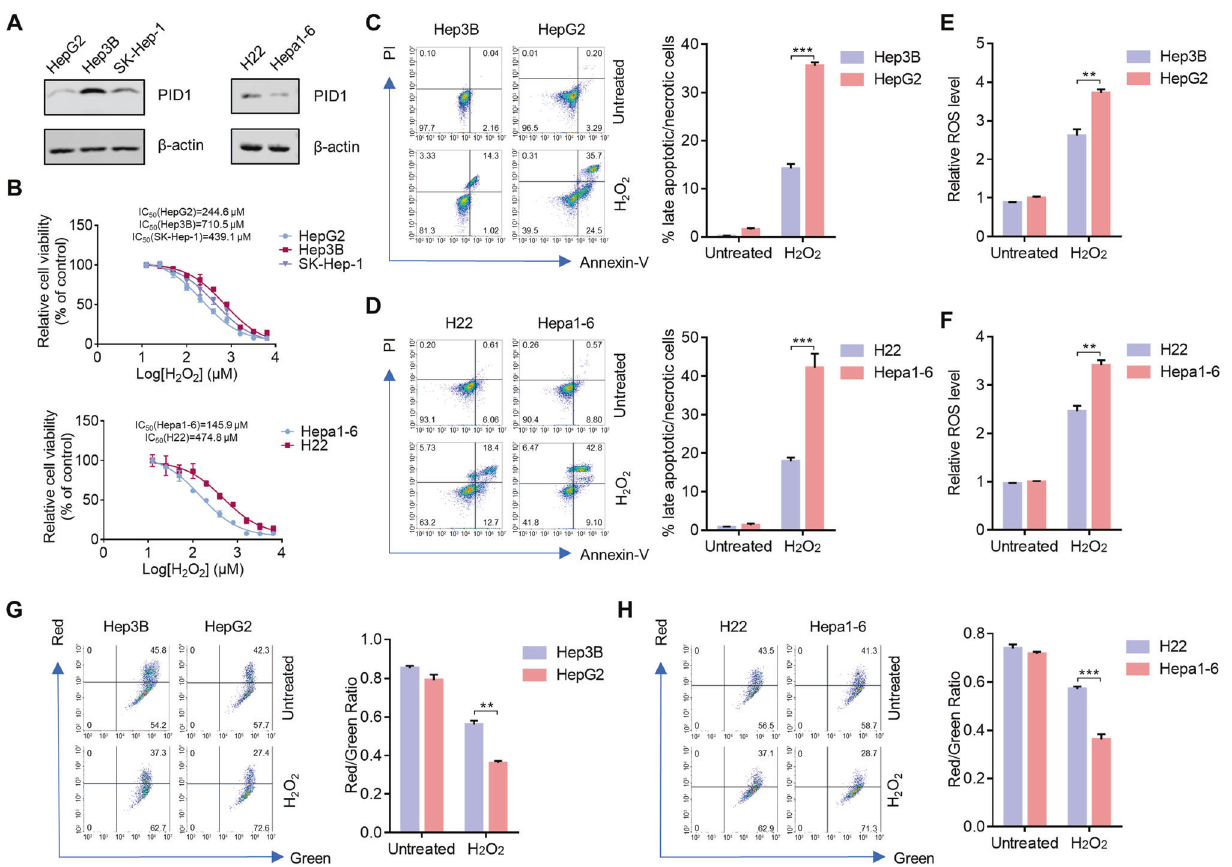
Fig. 1 PID1 levels predicted resistance to mitochondria-dependent apoptosis. A Protein levels of PID1 in three human hepatoma cell lines (Hep3B, HepG2 and SK-Hep-1) and two mice hepatoma cell lines (H22, Hepa1 – 6). B Cell viability curves of three human hepatoma cell lines and two mice hepatoma cell lines treated with the indicated doses of H 2 O 2 for 24 h. C – D Flow cytometry analysis measuring apoptosis in four hepatoma cell lines treated with H 2 O 2 (200 μ M) for 24 h. E – F H 2 DCFDA probe was used to detect intracellular ROS in four hepatoma cell lines treated with H 2 O 2 (200 μ M) for 24 h by fl ow cytometry analysis, and mean fl uorescence intensity (MFI) was calculated. G – H JC-1 probe was used to detect mitochondrial membrane potential in four hepatoma cell lines treated with H 2 O 2 (200 μ M) for 24 h by fl ow cytometry analysis, and Red/Green Ratio was calculated. Data are expressed as mean ± SD ( n = 3). ** p < 0.01; *** p <